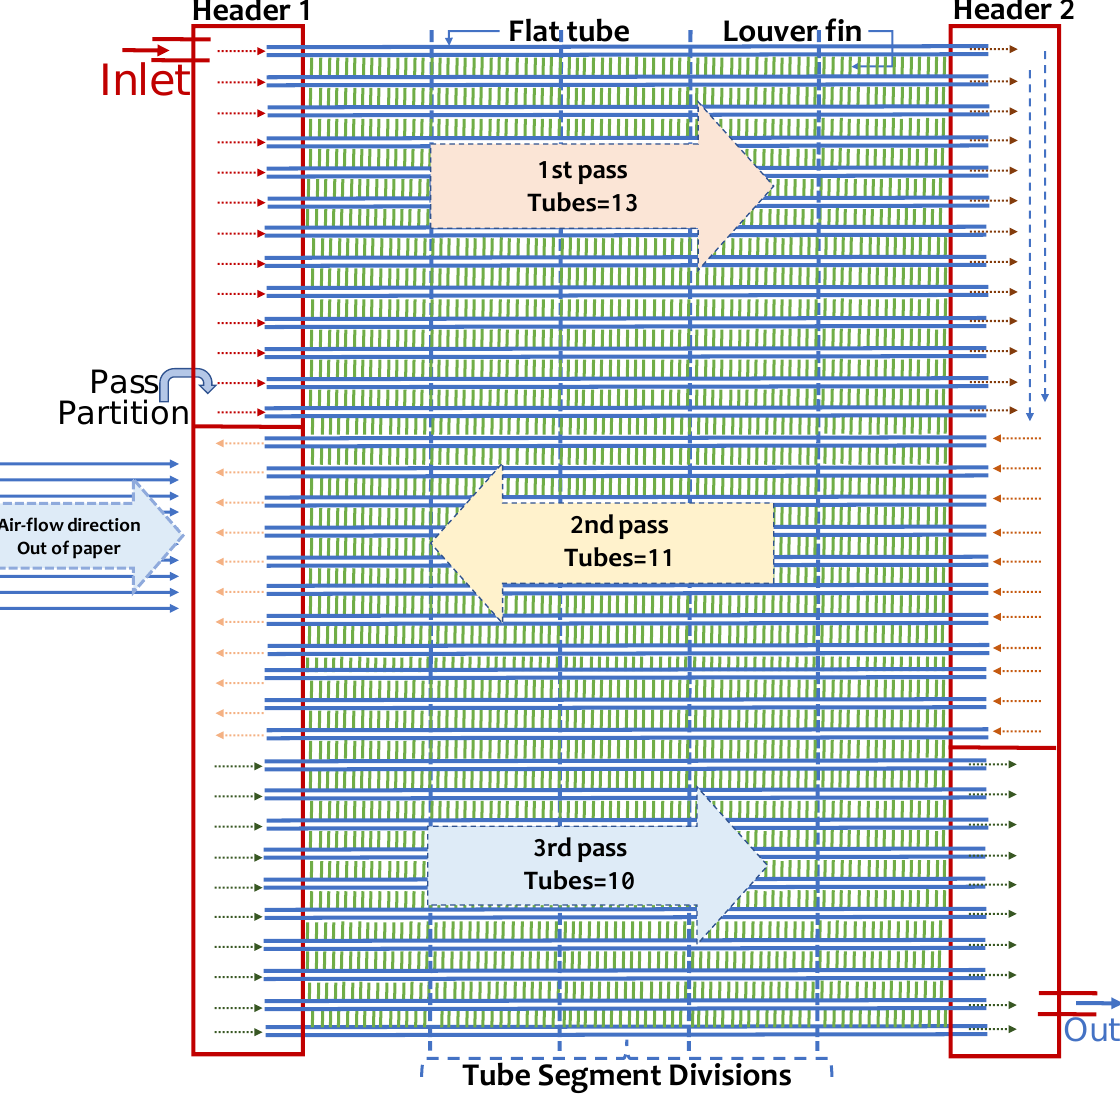
Figure 2. CO 2 Microchannel gas cooler baseline configuration. Table 1. Microchannel CO 2 gas cooler baseline geometric specifications.